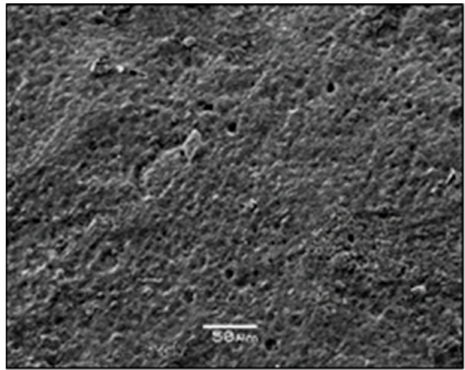
Figure 24. Rubber surface under treatment R2.